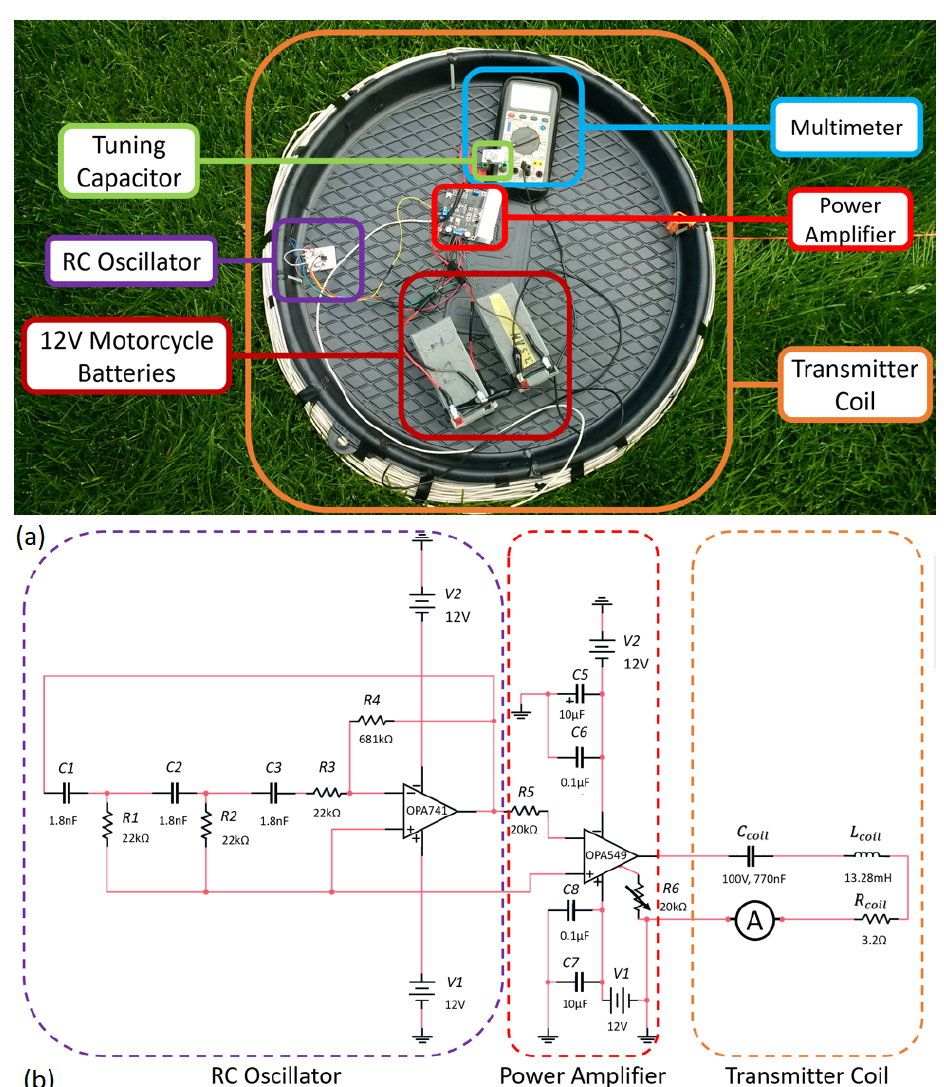
Figure 4. (a) Low-cost CSM-EM T x system powered by two 12V motorcycle batteries. The RC oscillator generates an AC signal at a given frequency, which is amplified by the power amplifier before being passed into the T x coil to generate an AC signal and corresponding magnetic field. The DMM (ammeter setting) measures the alternating current passing through the 0.61m diameter T x coil. (b) CSM-EM T x circuit diagram that can be split into three primary modules: the RC oscillator, the power amplifier, and the T x coil (with tuning capacitor). The circuit is composed of basic electronic components along with an OPA549 power amplifier breakout board. Resistor R 5 was included to allow sustained regenerative feedback in the circuit and is not part of a specific T x